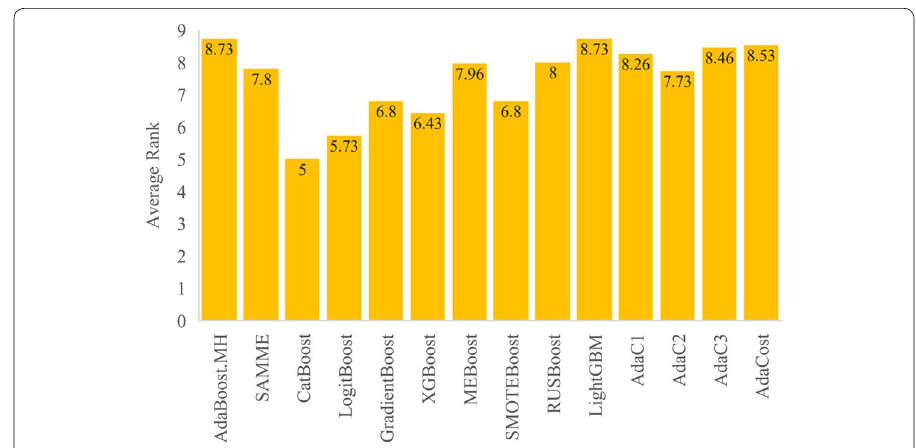
Fig. 3 Average ranks obtained from Friedman test based on the